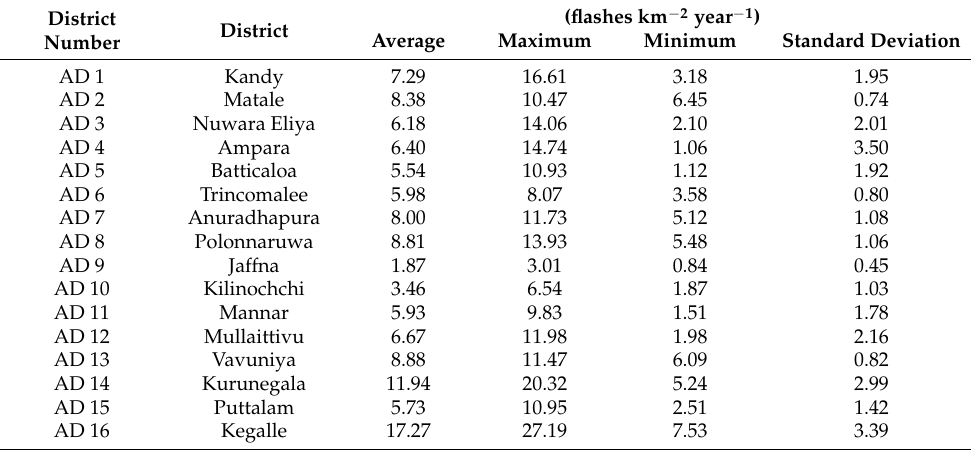
Table A6. Statistics of the variations of the lightning flash density in each administrative district of Sri Lanka, based on the 1998–2014 LIS Data from the TRMM